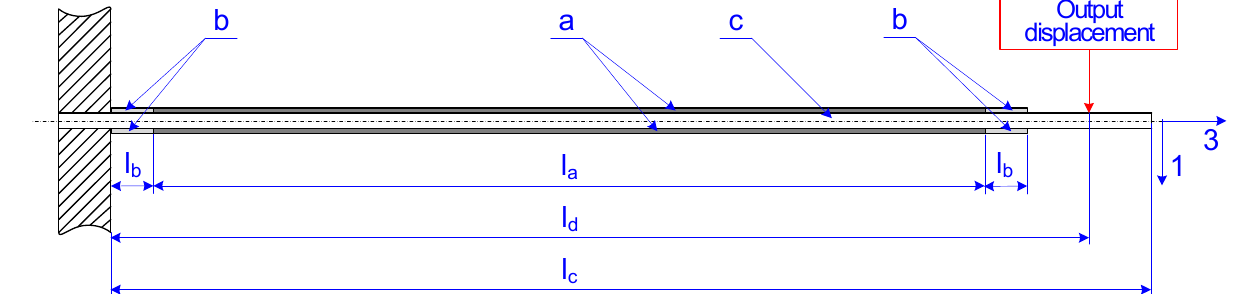
Figure 1. Main parts of a cross section of the bimorph: a, active parts of MFC patches; b, passive parts of MFC patches; c, a carrier layer; l a , lengths of areas no a; l b , lengths of areas no b; l c , lengths of area no c; l d , distance between bimorph clamping assembly and displacement measurement point; 1, a perpendicular axis to the longitudinal axis of the carrier layer; 2, a parallel axis to the longitudinal axis of the carrier layer.